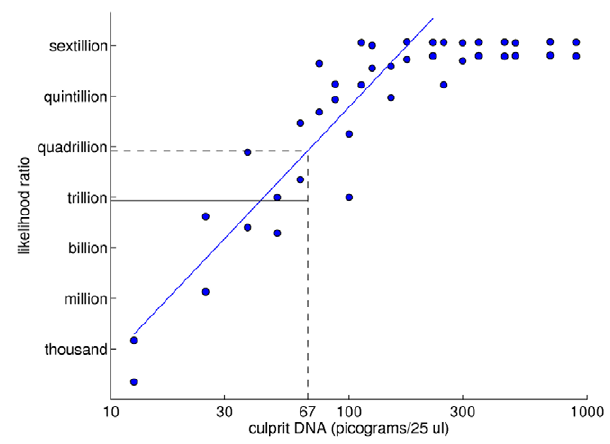
Figure 9. Using a linear relationship to predict match information from DNA quantity in a criminal case. The linear regression of log(LR) match information (y-axis) versus log(culprit DNA) (x-axis) is used here as a calibration curve for the LR1 method. For a mass of 67 pg of culprit DNA, the regression line shows an expected LR of 10 15 . With the 12 STR loci actually examined in the homicide case (instead of the validation study’s 15 STR loci), we expect an 80% information reduction to a LR of approximately 10 12